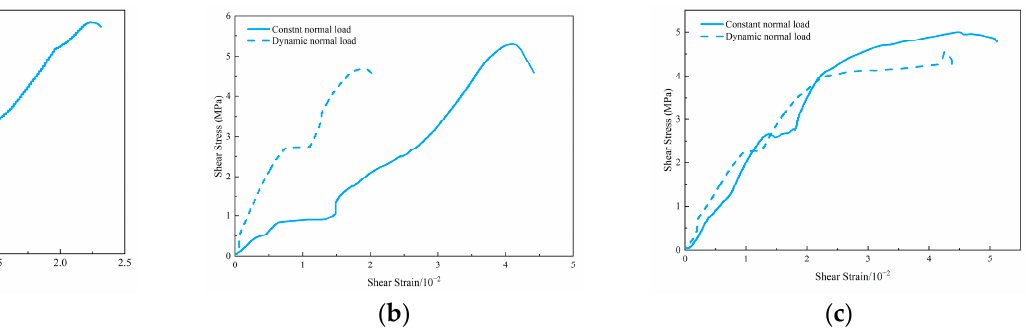
Figure 5. Shear stress–strain curves under different normal loads. Normal loads of ( a ) 10 kN, ( b ) 30 kN and ( c ) 50 kN.